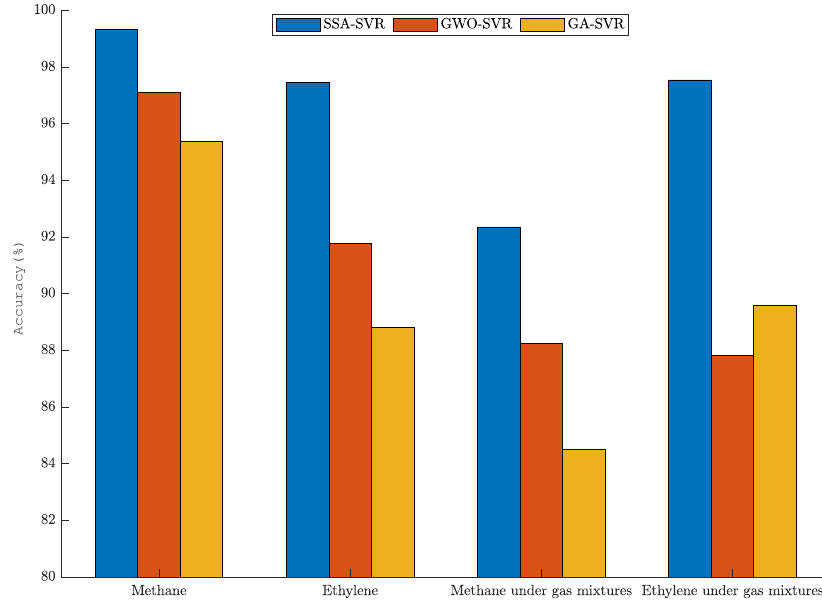
Figure 8. Gas-concentration-prediction